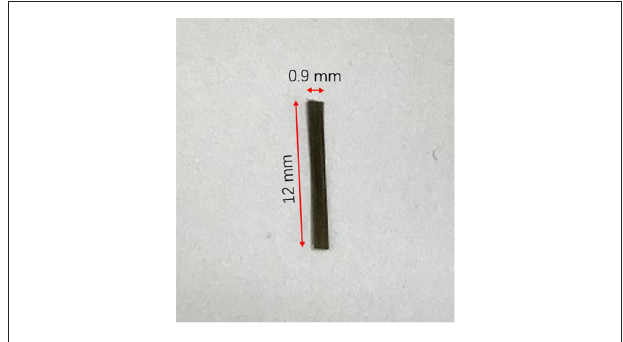
FIGURE 1 | Basalt fiber.